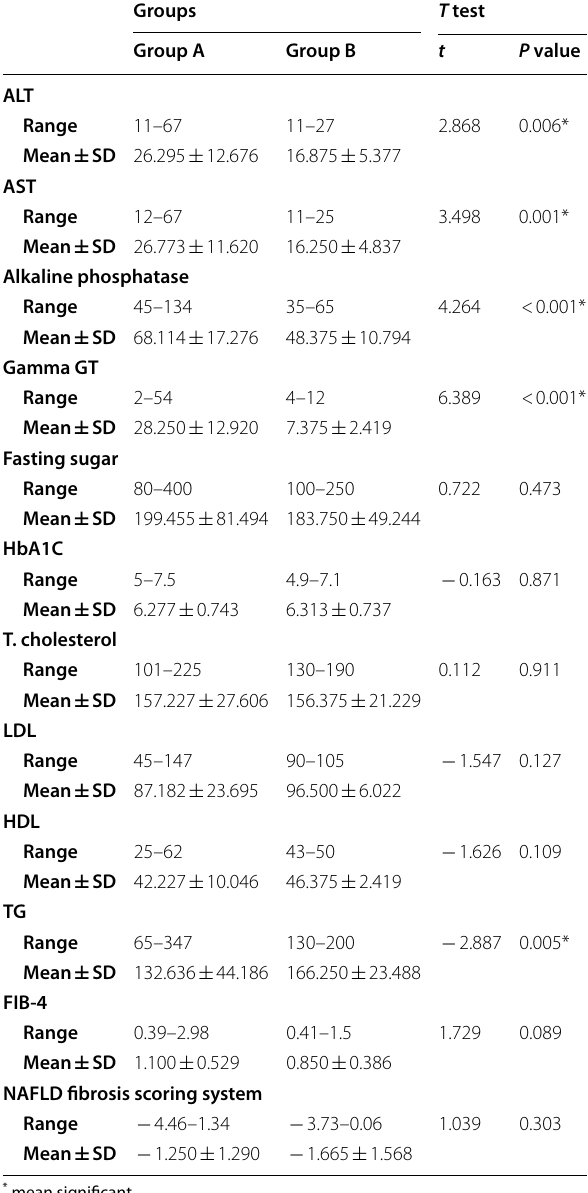
Table 3 Full hepatic and metabolic profile among group A versus group